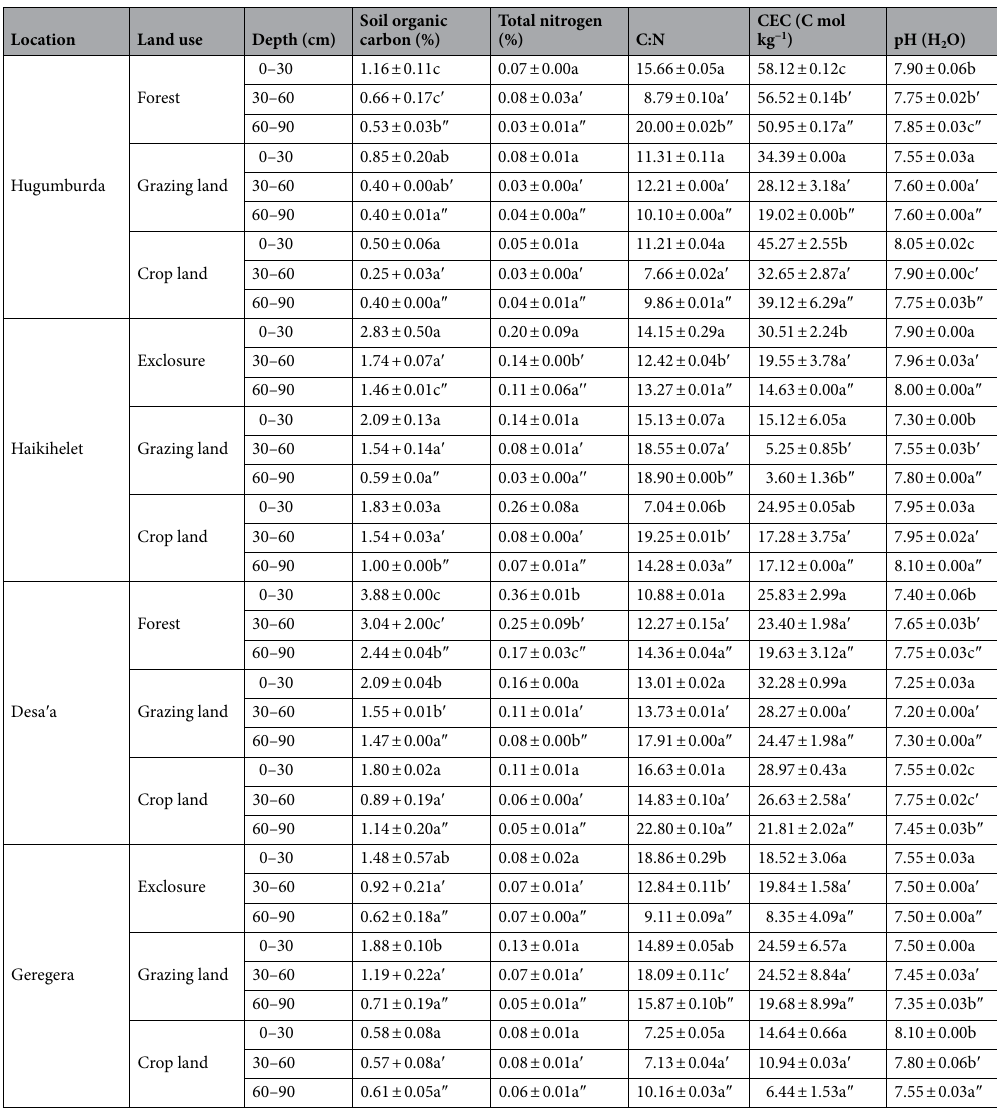
Table 2. Soil organic carbon and total nitrogen concentrations, C:N ratio, cation exchange capacity and pH under different land use types and soil depths in the study locations. ± Mean followed by standard errors. Letters after the standard errors indicate significant differences (P < 0.05) between land uses at 0–30 cm (a), 30–60 cm (a ′ ) and 60–90 cm (a ″